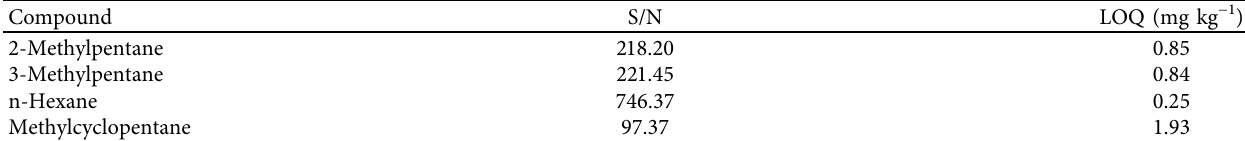
Table 4: Theoretical quantitation limit (LOQ) and signal-to-noise (S/N) based on 17mg kg − 1